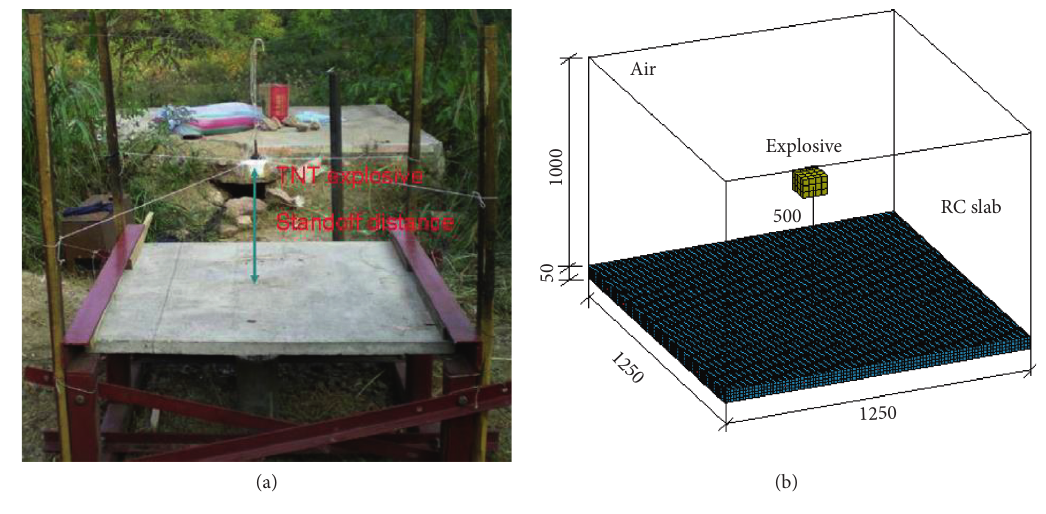
Figure 2: (a) Experimental model [9] and (b) FE